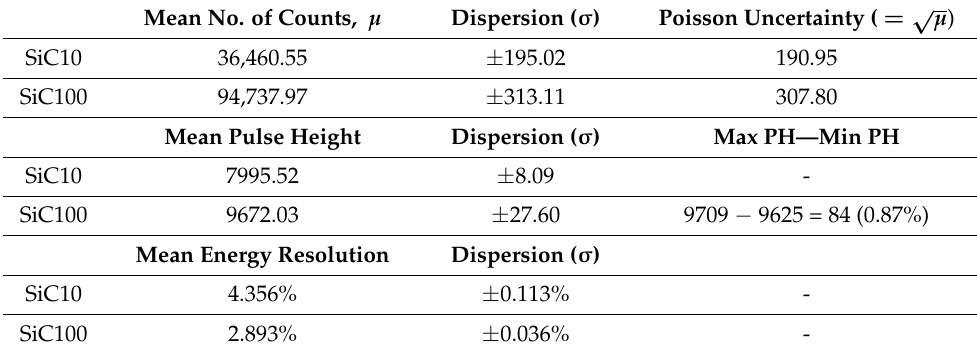
Figure 3. Time evolution of the number of counts (black), the mean pulse height (blue) and the energy resolution (green) for the 10 µ m SiC ( top ) and the 100 µ m SiC ( bottom ) under irradiation with quasi-monochromatic 4.7 and 4.3 MeV α s, respectively. SiC10 and SiC100 alpha irradiation lasted for 55 and 170 h, respectively. Each of the points corresponds to a 300 s ensemble. On the right, the dispersion of data is projected on the y-axis, and the mean value of the three quantities was computed, along with its standard deviation. Table 1. Summary of the mean number of counts, pulse height and energy resolution measured during the alpha particle